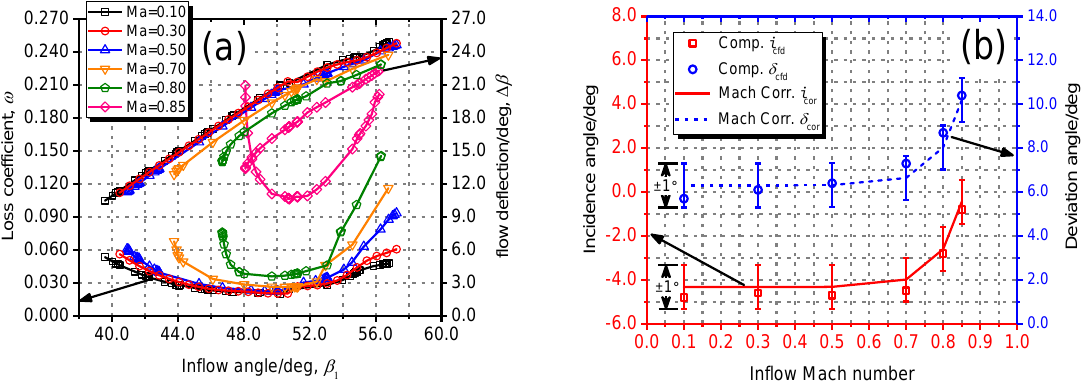
Figure 17. Performances for a certain splittered cascade: ( a ) total pressure loss and deflection angle vs. inflow angle characteristics and ( b ) variations of incidence and deviation angles with Mach number. Inlet metal angle 53°, camber 30°, ES 1.60, t max / C 0.08, CR 0.50, PP 0.5.